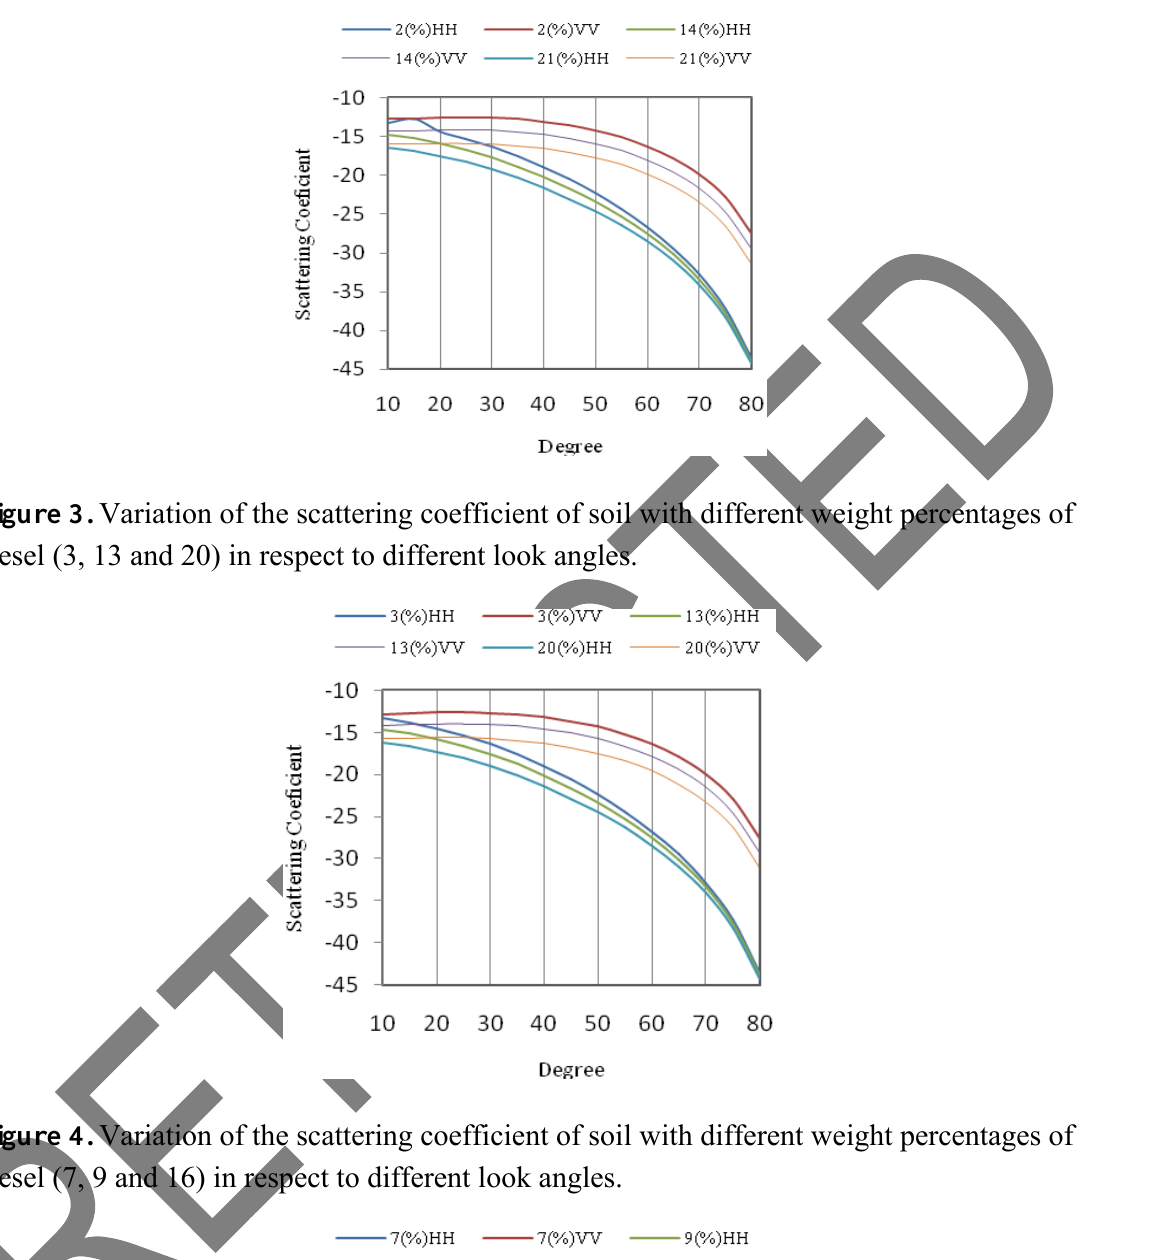
Figure 2. Variation of the scattering coefficient of soil with different weight percentages of diesel (2, 14 and 21) in respect to different look angles.